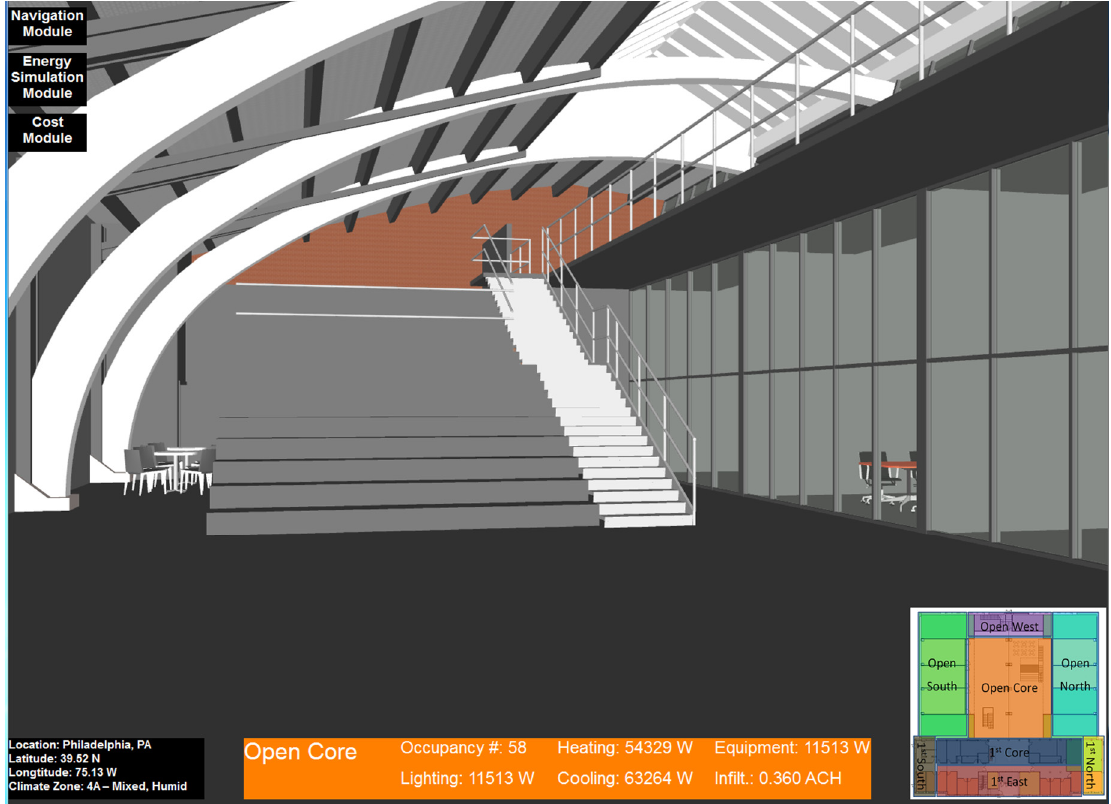
Figure 2. A snapshot of the Open Core space of the case building during a walkthrough within the building’s interior